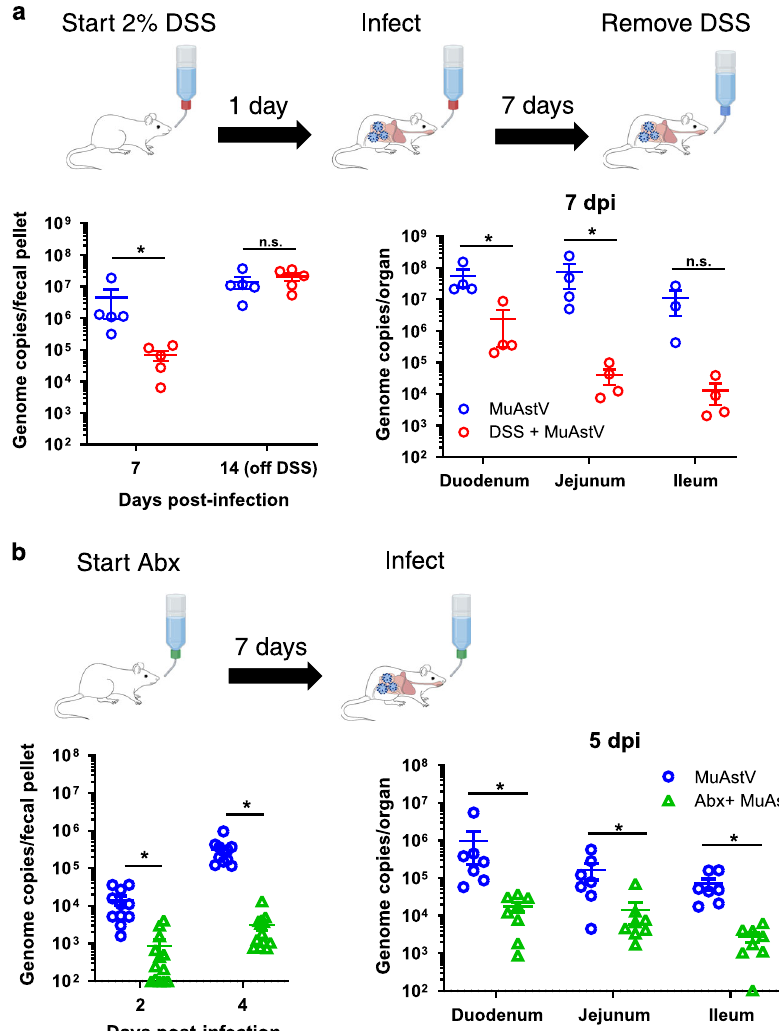
Fig. 3 Disruption of mucus secretion resulted in reduced virus infection and shedding. a 8-week-old mice were treated with 2% DSS for 1 day prior to infection and removed at 7 dpi. Treated mice (DSS + MuAstV; n = 5) shed signi fi cantly less virus in comparison with untreated mice (MuAstV; n = 5) ( p = 0.0079), which was consistent with signi fi cantly reduced infection ( n = 4/group) in the duodenum ( p = 0.0286), jejunum ( p = 0.0286), and a trending reduction in the ileum ( p = 0.0571) at 7 dpi. Note one ileum sample from the untreated group is missing due to poor RNA yield. Levels of virus shed in the feces was not signi fi cantly different at 14 dpi ( p = 0.5476), corresponding to 7 days after returning the DSS-treated group to water. Data shown are from a single experiment. b 8-week-old mice were treated with broad-spectrum antibiotics for 7 days prior to infection. Bacterial clearance from the gut was con fi rmed by fecal homogenates cultured on blood-agar plates incubated for 2 days under anaerobic conditions. Treated mice (Abx + MuAstV; n = 13) shed signi fi cantly less virus in comparison with untreated mice (MuAstV; n = 11) at 2 dpi ( p < 0.0001) and 4 dpi ( p < 0.0001), which was consistent with signi fi cantly reduced infection in the duodenum ( p = 0.0003), jejunum ( p = 0.0140), and ileum ( p = 0.0003) from treated ( n = 8) and untreated mice ( n = 7). Data shown are from two independent experiments. For both panels, mean and standard error of the mean (SEM) are noted for each group. Y -axes are drawn at the lower limit of detection for the qRT-PCR assay. Signi fi cant differences between groups tested by a two-sided Mann – Whitney U are noted (*). Abx antibiotics. Source data are provided as a Source Data fi with cage changes after the fi rst and last gavage. For the duration of the experiment, mice were given drinking water containing vancomycin (500 mg/L), ampicillin (1g/L), neomycin (1g/L), and metronidazole (1g/L). Feces were homogenized using 1mm glass beads and tenfold dilutions were made in PBS. Dilutions from 1:10 1 to 1:10 6 were plated on blood-agar plates and cultured in anaerobic chambers for 2 days. The absence of bacterial colonies was used to con fi rm clearance of culturable gut bacteria. Feces from untreated animals was used as a positive control. For experiments using EPEC (Xen-14, PerkinElmer), 7-day-old mice were mock or MuAstV-infected and 3 days later orally inoculated with 2.15 – 5.50× 10 5 colony-forming units (CFU)/ μ L from overnight cultures of EPEC. Small intestines were collected in 0.5 mL of PBS and homogenized with either a hand blender or 1mm glass beads (NextAdvance) in a Bullet Blender Tissue Homogenizer (NextAdvance) for 8min at level 8 before tenfold dilutions were plated on MacConkey agar (Becton Dickson and Company) and CFUs were quanti fi ed the following day.